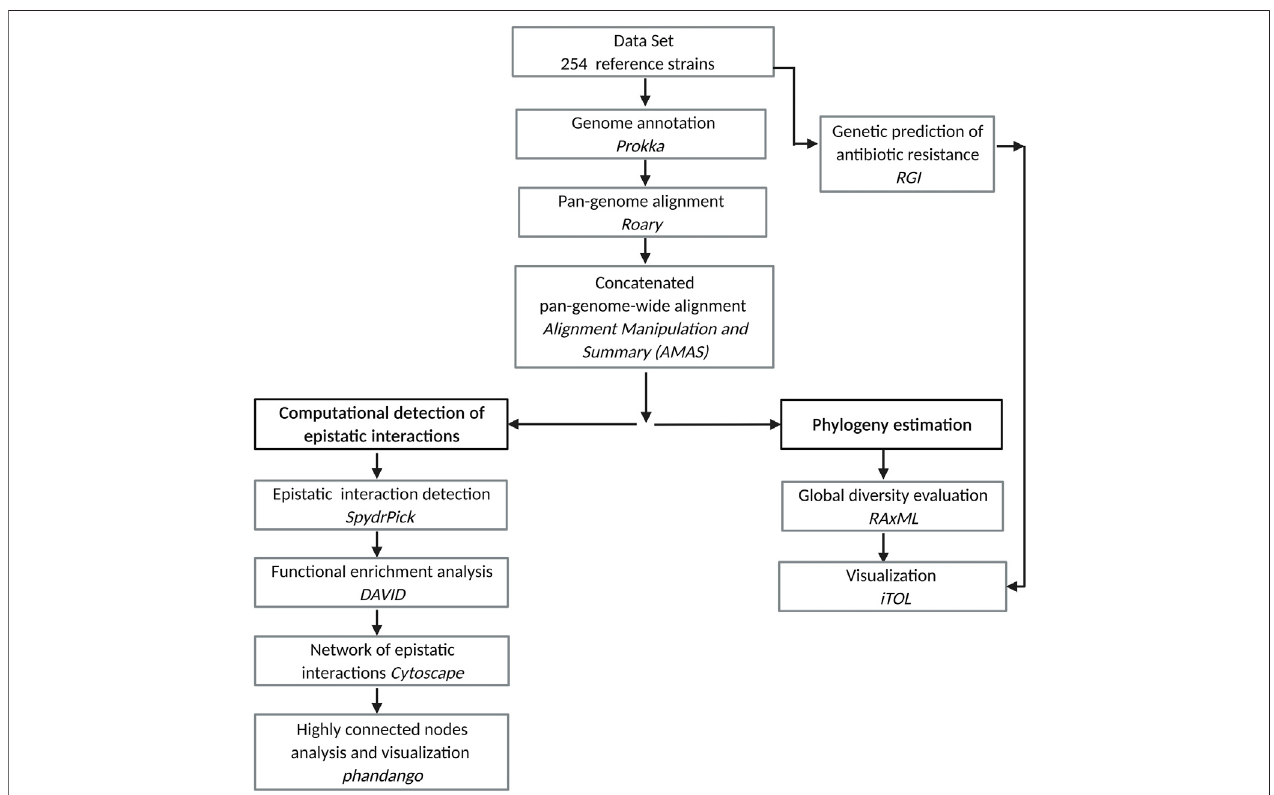
FIGURE 1 | Pipeline for the study of epistatic interactions in